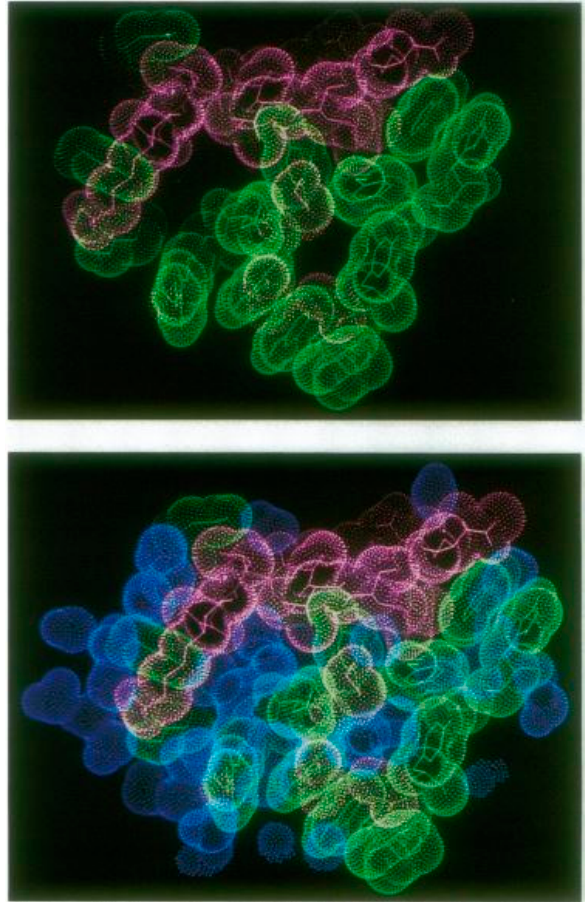
Figure 3 . 3D structure at 1.8 Å resolution of the anti-lysozyme Fv fragment of Mab D1.3. Upper frame: van der Waals surface of antibody residues (in green ) interacting with residues of lysozyme (in pink ); Lower frame: the same model showing cavities and channels filled with water molecules (in blue ) after complex formation. There are more water molecules at the interface than in the free binding sites and they contribute H-bonds that stabilize the complex. The association is not driven by an hydrophobic entropy effect arising from the extrusion of water from the interface but by a large negative enthalpy arising from H-bonds and van der Waals interactions (Bhat et al., 1994 [65]).